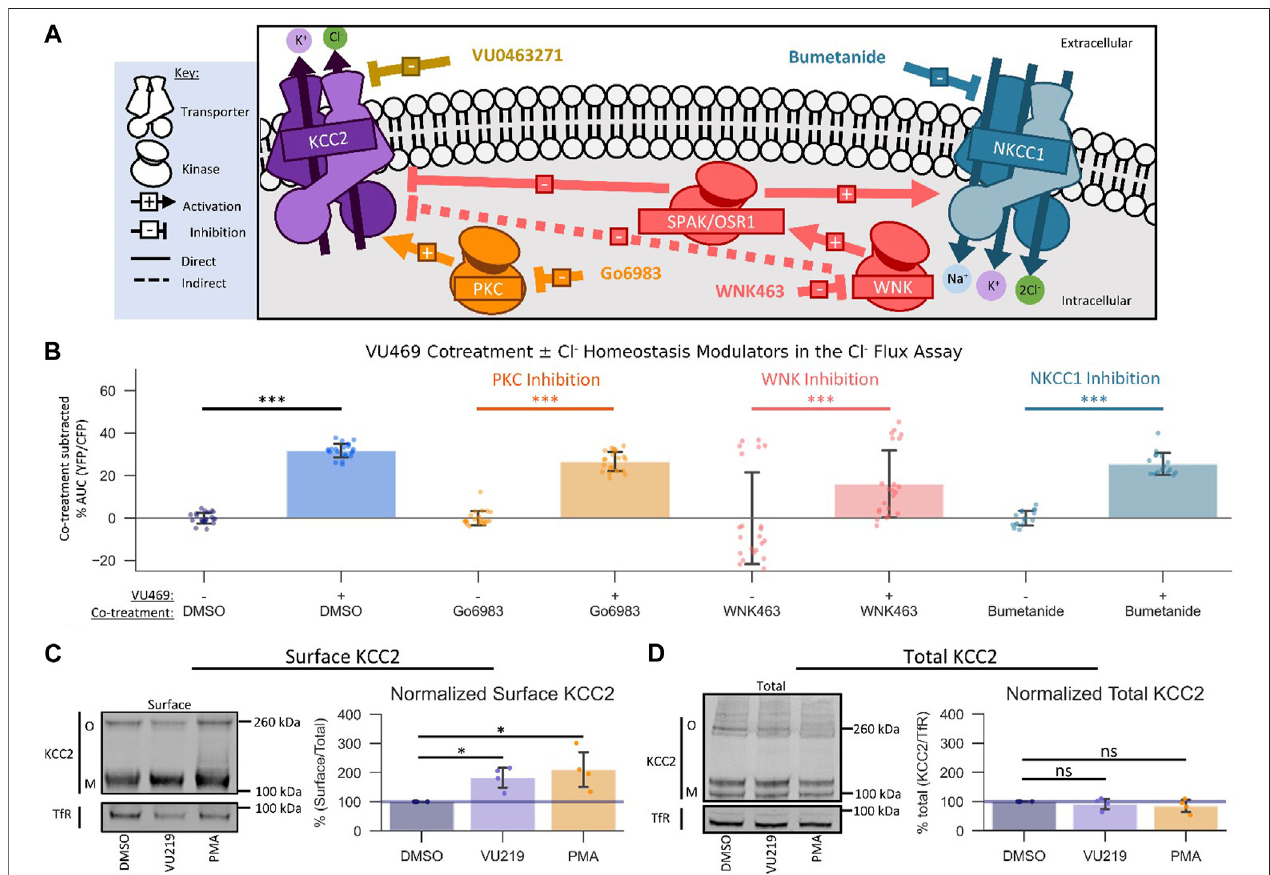
FIGURE 4| VU0500469 potentiates KCC2 by aunique mechanism. All experiments conducted using the Cl − fl ux assay in HEK-293 cells overexpressing KCC2 at 37 ° C, unless otherwise noted. (A) Schematic depicting investigated small molecule targets known to regulate Cl − homeostasis. (B) Co-treatment of modulators of Cl − homeostasis from (A) with or without VU0500469 ( n ≥ 16). (C) Left: representative Western blot of biotinylated surface fraction from cells treated with vehicle (DMSO), VU0916219 (VU219), or the positive control phorbol 12-myristate 13-acetate (PMA). Band intensity was normalized to Transferrin Receptor (TfR) levels. O, oligomericKCC2, M,monomericKCC2.Right:quanti fi cationofSurfaceKCC2/Total KCC2normalizedtoTfRlevels. (D) Left:representative Westernblotoftotalprotein fraction from cells treated as in (C) . Right: quanti fi cation of total KCC2 normalized to TfR levels. ( n = 4) Error bars represent SD. Statistical signi fi cance calculated